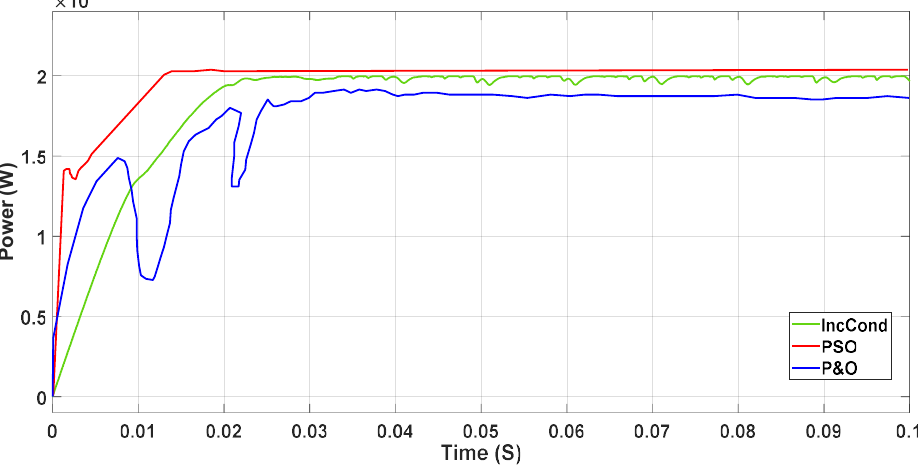
Figure 29. PSO, P&O, and IncCond MPPTs comparison at 1 kW irradiance and 25 C.